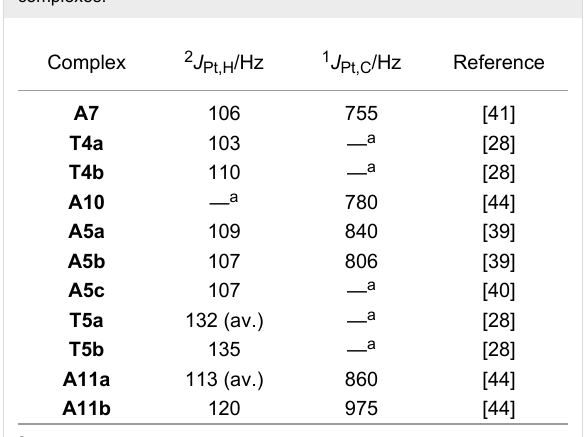
Figure 14: NMR coupling constants used for the characterization of three-coordinate Pt(II) species.